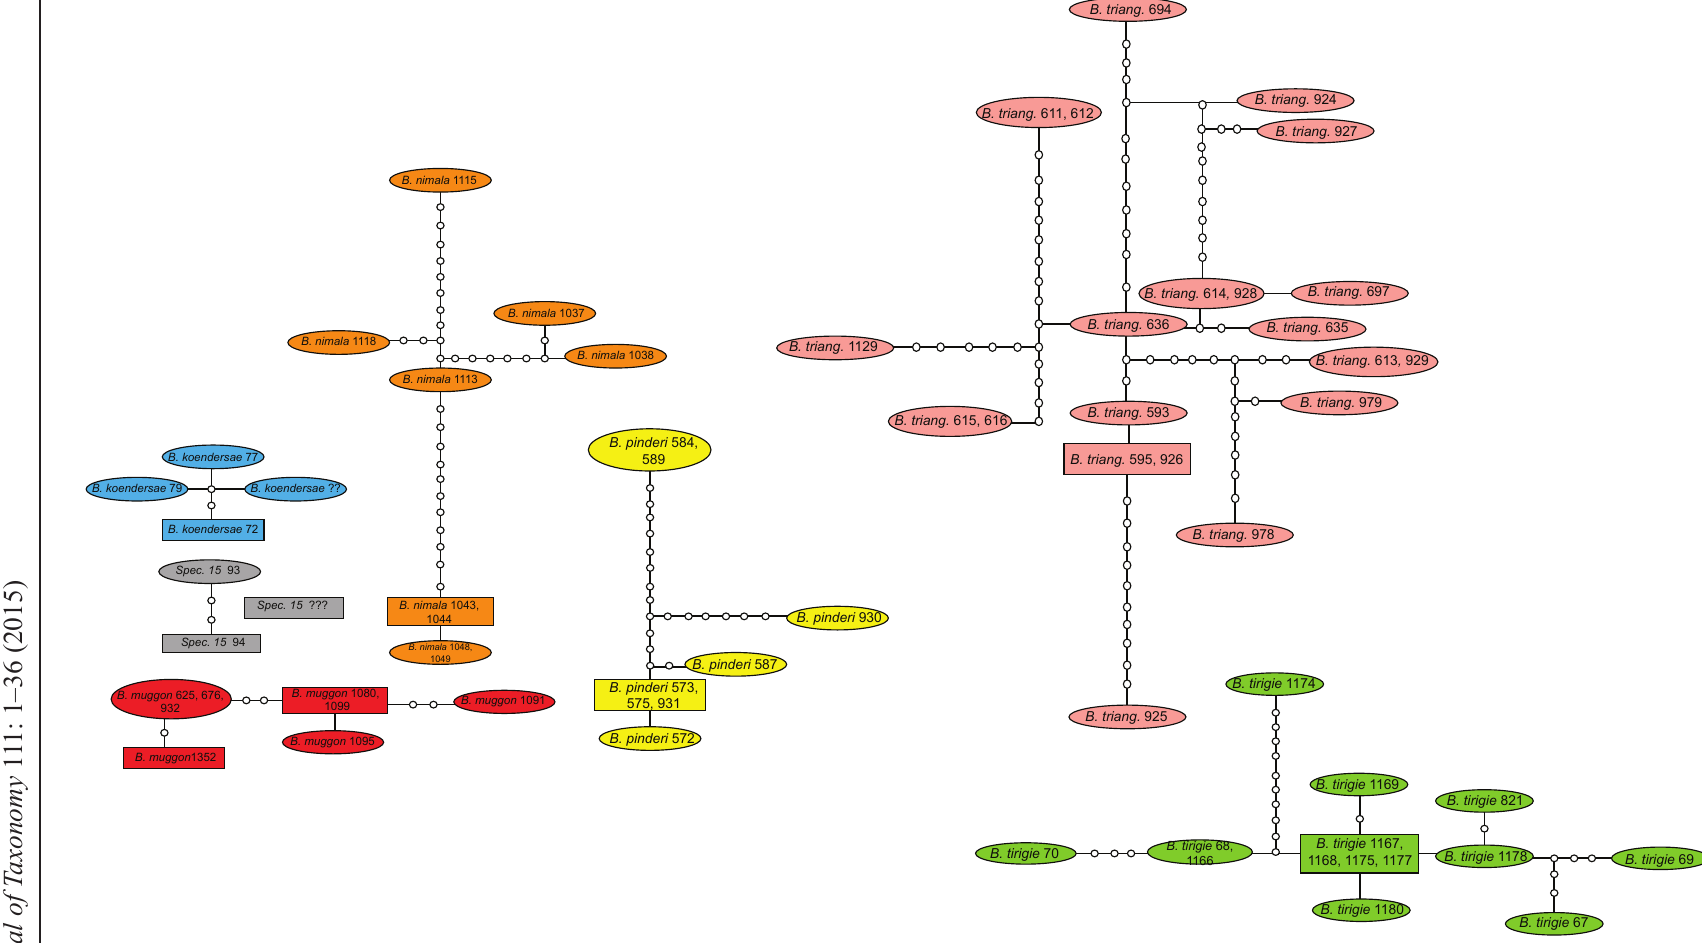
Fig. 3. Parsimonius networks, based on cOI sequences of the Bennelongia nimala and B. triangulata lineages. squares represent ancestral sequences (or haplotypes), small circles missing haplotypes. The size of squares and large ovals is proportional to the number of individuals with the same sequence in the analysed population. the networks were constructed with up to 14 mutations steps connecting different sequences or haplotypes. Different phylogenetic clades are indicated by different colours (see Fig.